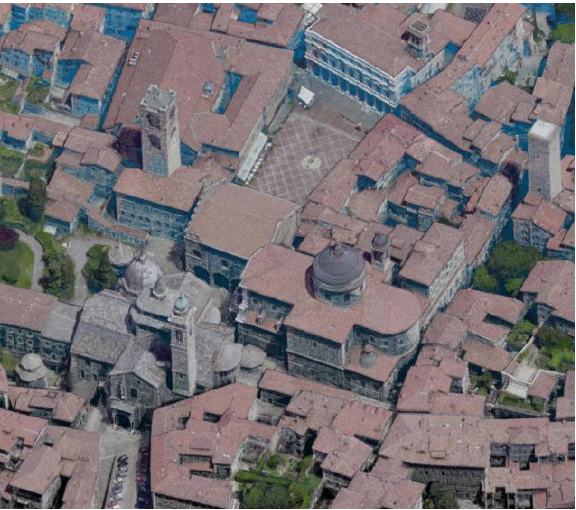
Figure 4. Close view of the shaded 3D point cloud (1 GSD resolution) of the historic centre.